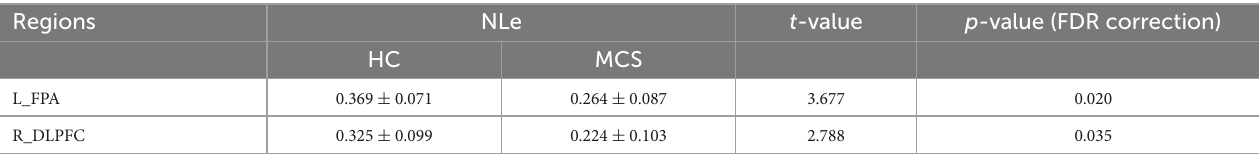
TABLE 4 Comparison of NLe between HC and MCS groups. Regions